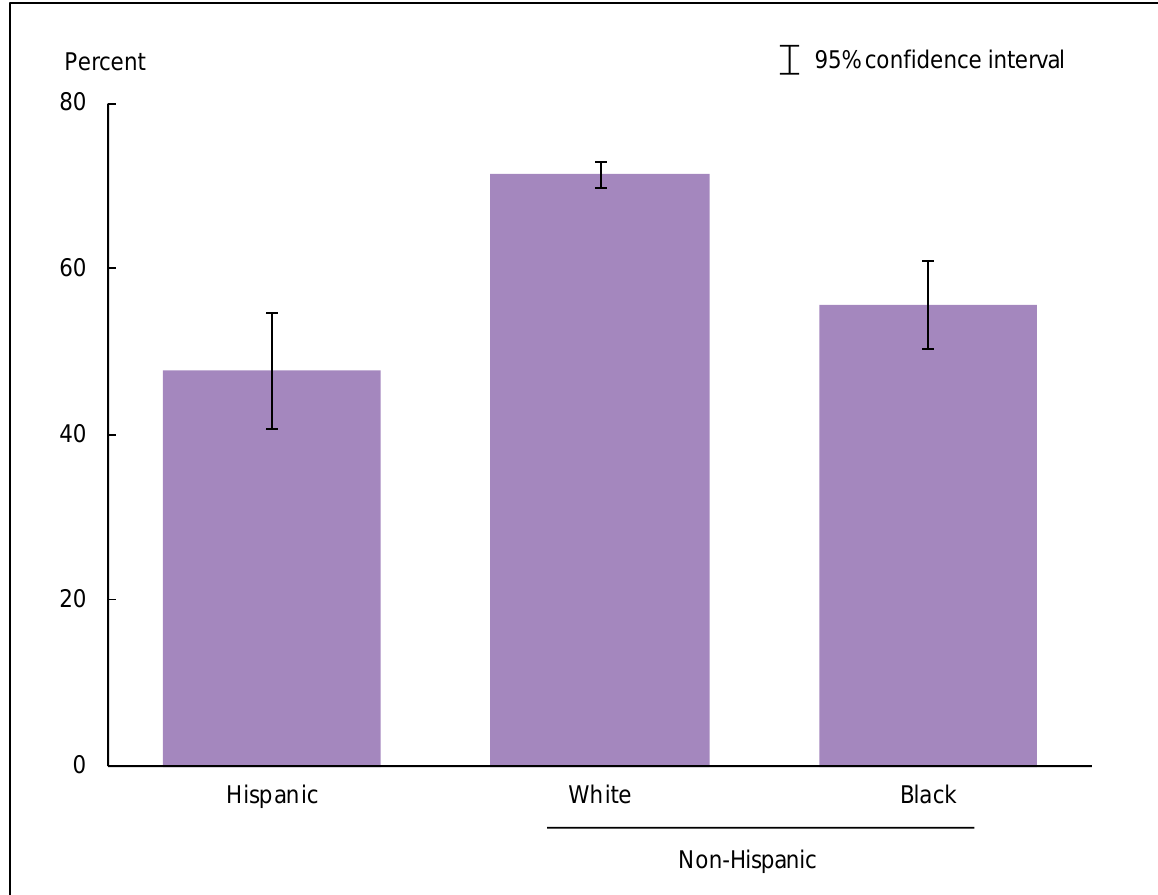
Figure 5.3. Percentage of adults aged 65 and over who had ever received a pneumococcal vaccination, by race and ethnicity: United States,